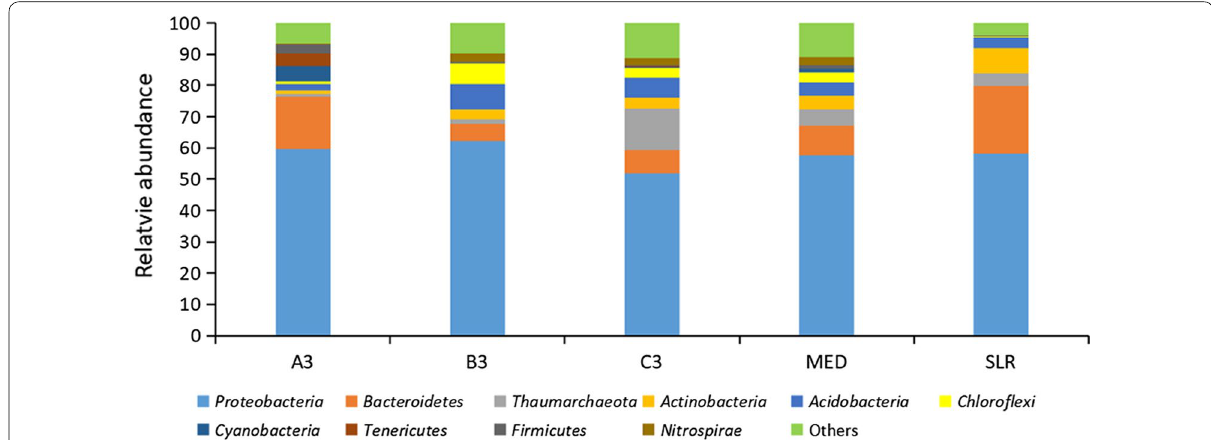
Fig. 5 The bacterial biodiversity in the sediments in the direction perpendicular to the shoreline. The map was generated from the highest abun- dance of the top 10 species at the phylum level. The symbol A3 (B3, C3): the sampling site near the leak point; MED: control site in Jiaozhou Bay; SLR: control site outside of Jiaozhou